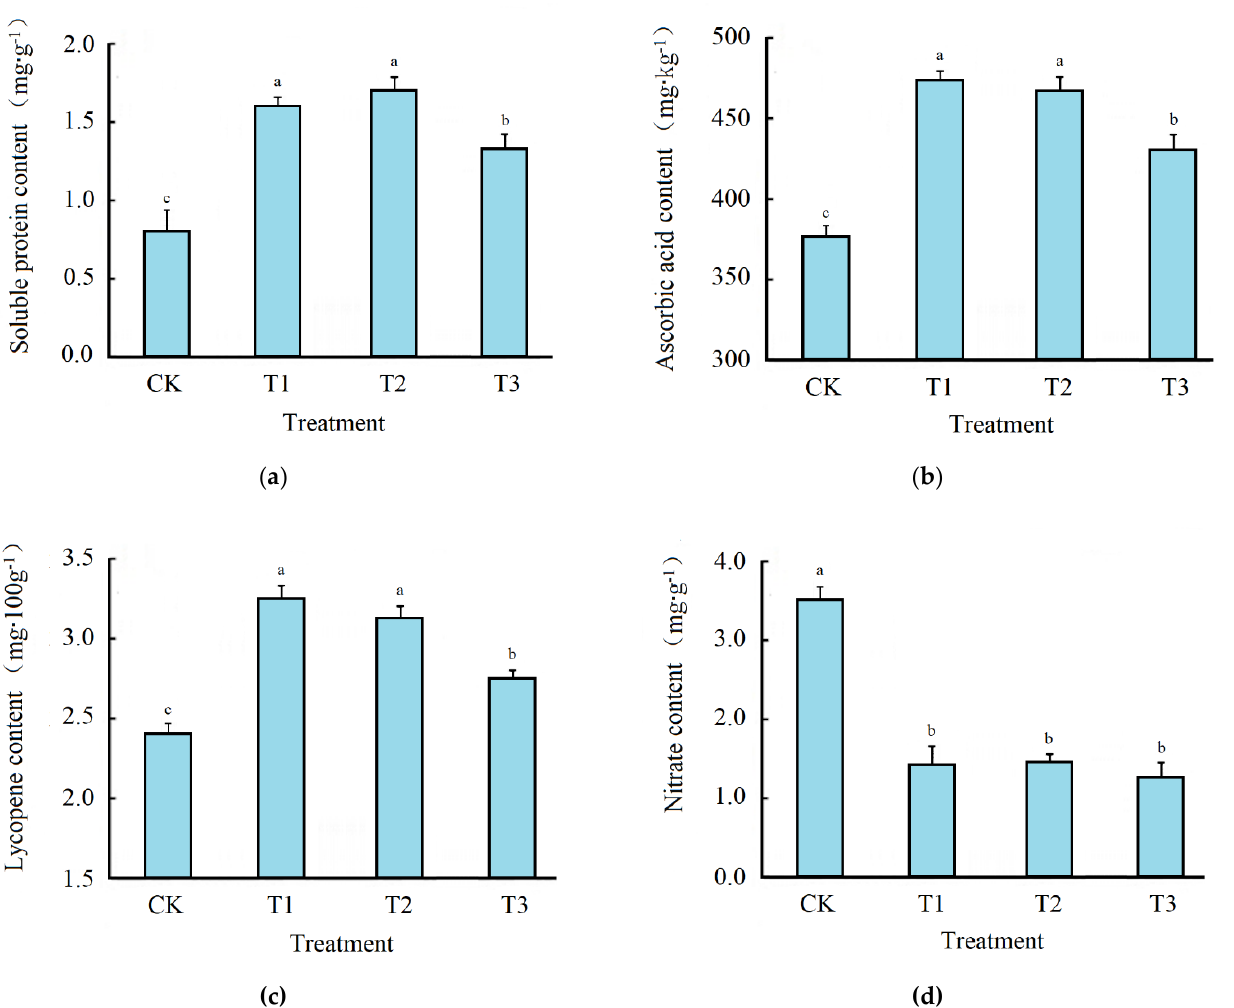
Figure 5. Effect of different abaxial leafy supplemental lighting treatments on nutrient and function quality of cherry tomato. ( a ) Soluble protein; ( b ) ascorbic acid; ( c ) lycopene; ( d ) nitrate. Tukey’s HSD test was used, and vertical bars represent the standard error of the means ( n = 15). Different letters indicate significant differences at p < 0.05 according to Tukey’s HSD test.